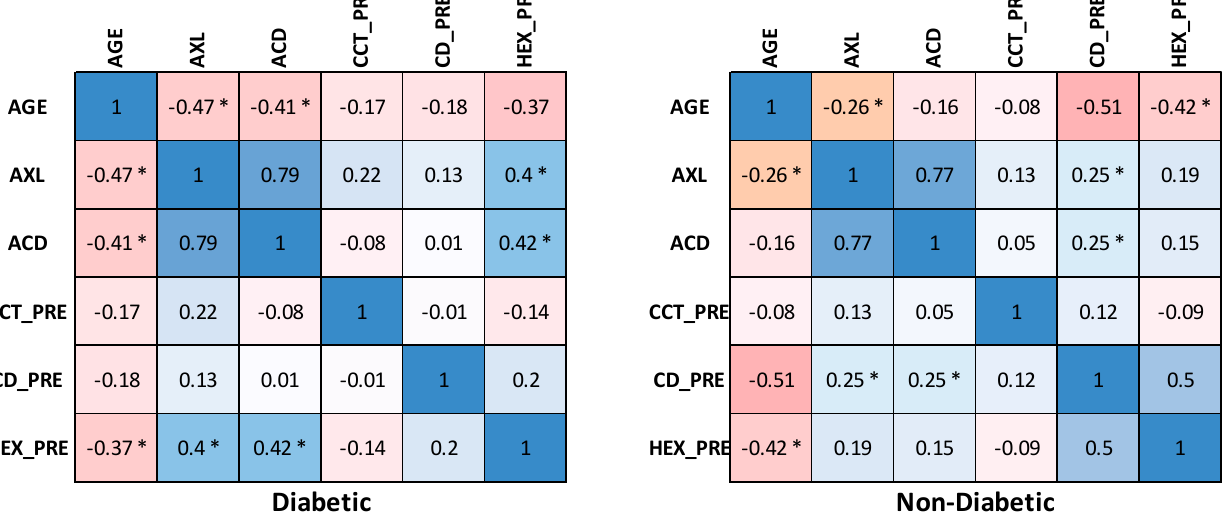
Figure 5. Correlation matrix between measured variables before the surgery. Legend: AXL, axial length; ACD, anterior chamber depth; CCT_PRE, central corneal thickness preoperative; CD_PRE, cell density preoperative; HEX_PRE, hexagonality of endothelial cells preoperative; * significance, p < 0.05. Table 1. Endothelial cell loss (cell/mm 2 ) (mean ±